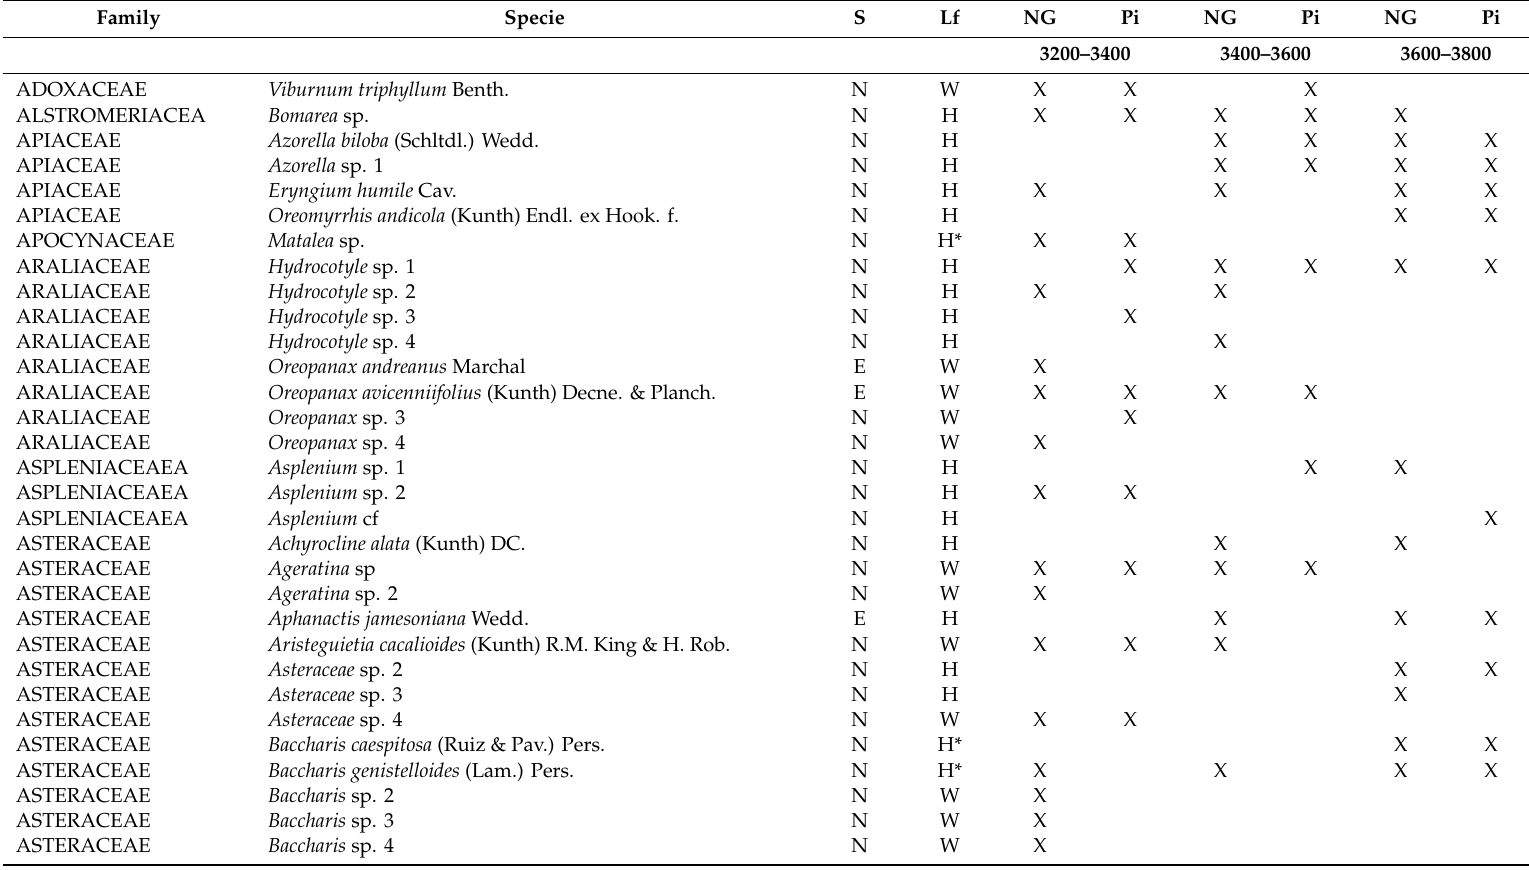
Table A1. Inventory of species classified by type of vegetation, natural grassland (NG) and pine plantation (Pi), and elevational range in m a.s.l. S = biogeographic current condition of the species in Ecuador (N = native, E = endemic, I = introduced), Lf = life form (H = herbaceous, H* = prostrate shrubs-sub shrubs and vines, W = woody plant). “X” represents the presence of the